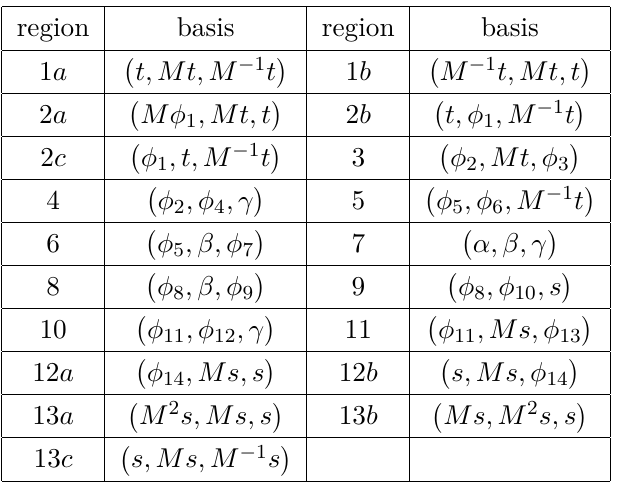
Table 4 . Bases of local WKB solutions for the 13 regions shown in figure